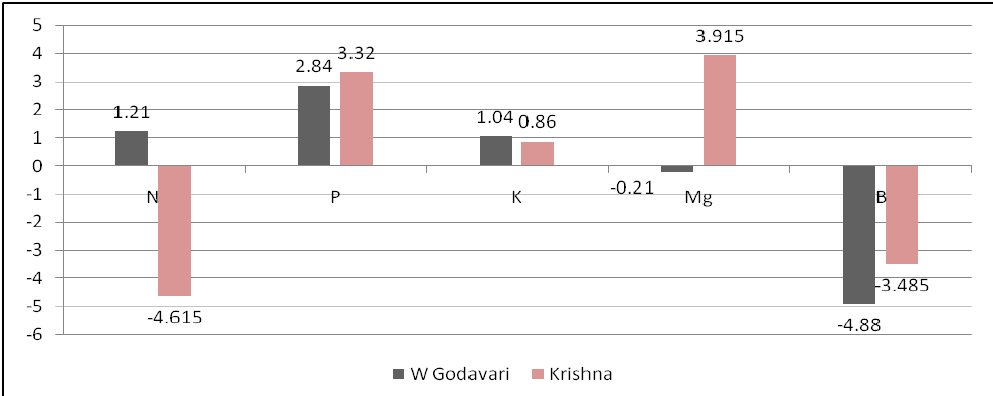
Figure 2. DRIS indices of Krishna and West Godavari Districts.